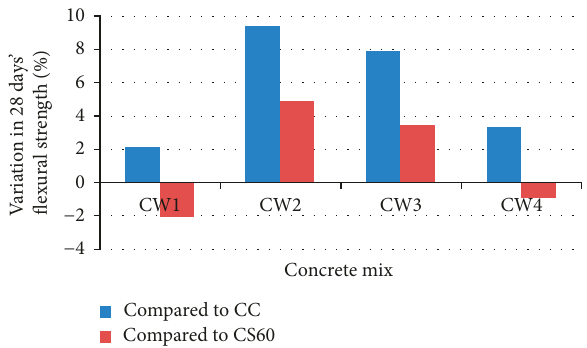
Figure 8: Variation in the flexural strength of the Type B mixes.